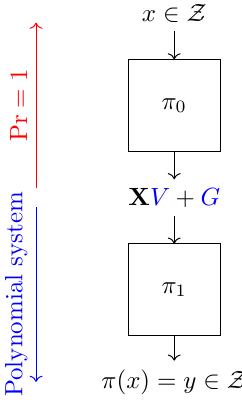
Figure 2: A 2-staged